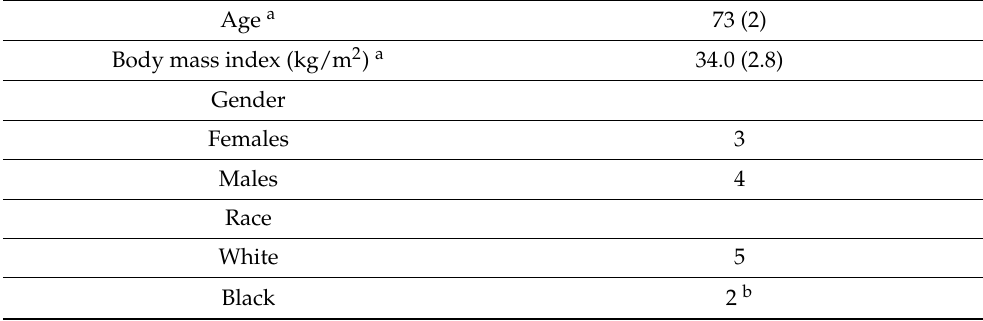
Table 1. Participant characteristics at